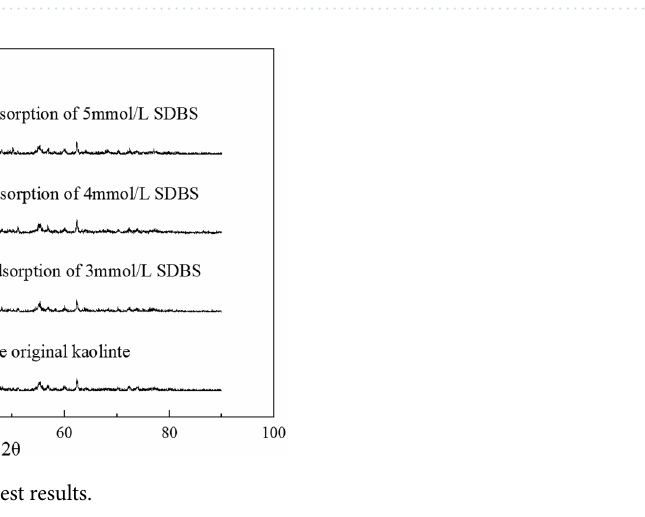
Figure 5. EDS scan of kaolinite before and after adsorption. ( a ) Original sample ( b ) 3 mmol/L SDBS after adsorption ( c ) 4 mmol/L SDBS after adsorption ( d ) 5 mmol/L SDBS after adsorption.